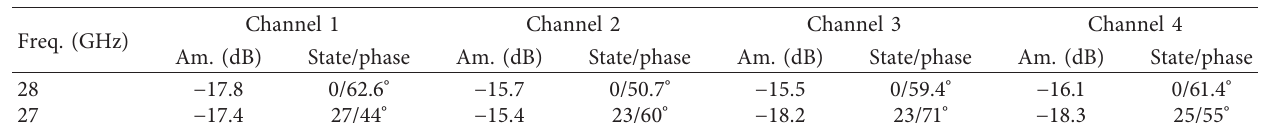
Figure 6: (a) Illustration of 2 × 2 MIMO antenna module; (b) photograph of bench test conducted to generate calibration database. Table 1: Calibration results.